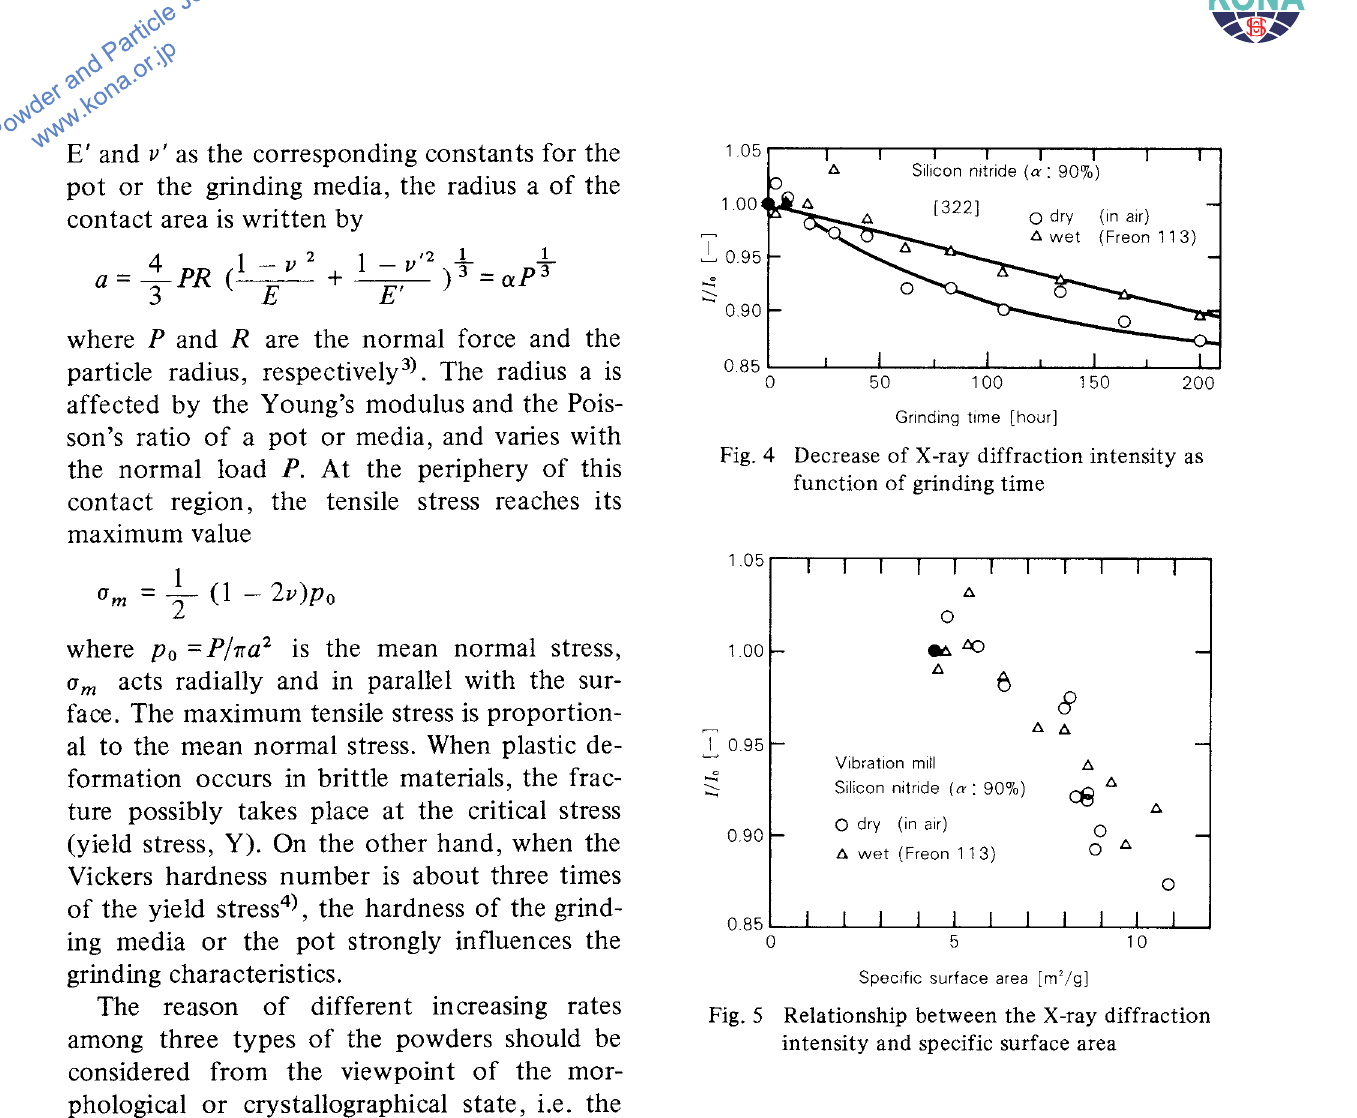
Fig. 5 Relationship between the X-ray diffraction intensity and specific surface